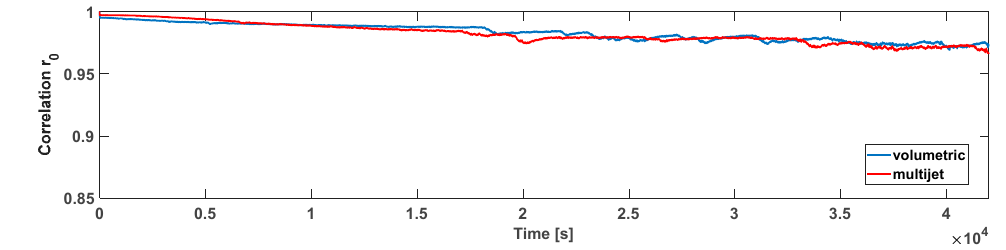
Figure 5. Correlations r 0 with a null water flow condition for both the water meters considered.